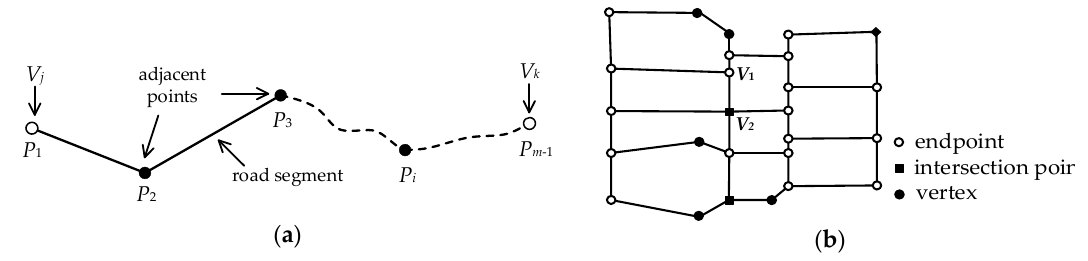
Figure 3. Representation model of a road network: ( a ) road and ( b ) road network G .